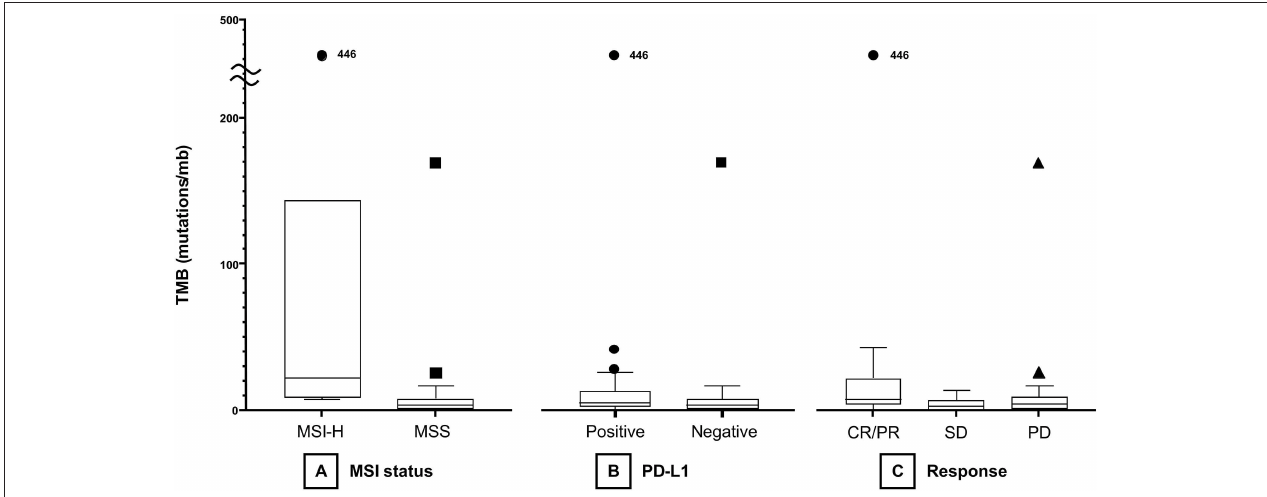
FIGURE 2 | Venn diagram illustrating relationships between PD-L1 positivity, MSI status, EBV positivity, and TMB. PD-L1, programmed death-ligand 1; MSI, microsatellite instability; EBV, Epstein–Barr virus; TMB, tumor mutational burden.